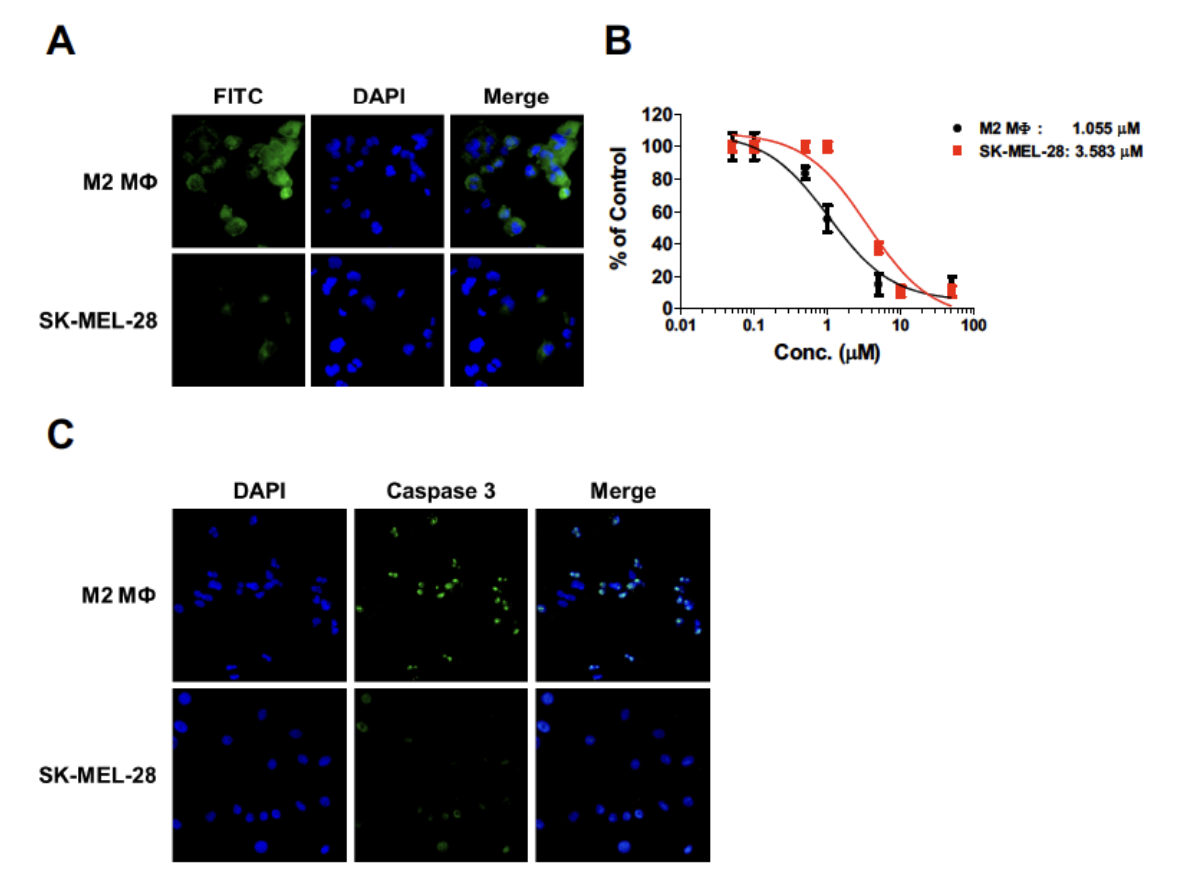
Figure 4. Cytotoxicity of melittin–dKLA in THP-1-derived M2 macrophages and SK-MEL-28 cells. Human monocytes (THP-1) were treated with 100 nM PMA for 24 h and cultured with the following: 20 ng/mL rhIL-4 and 20 ng/mL rhIL-13 for M2 macrophage differentiation. ( A ) M2 macrophages and SK-MEL-28 cells were treated with melittin conjugated FITC (100 nM). Melittin–FITC bound to cells was determined by fluorescence microscopy. ( B ) M2 macrophages and SK-MEL-28 cells were treated with melittin–dKLA by concentrations from 0.05 µ M to 50 µ M. Cell viability was measured by CCK-8 assay. Data are presented as the means ± SD. ( C ) Cells were treated with melittin–dKLA (1 µ M). Expression of caspase 3 was observed by fluorescence microscopy.